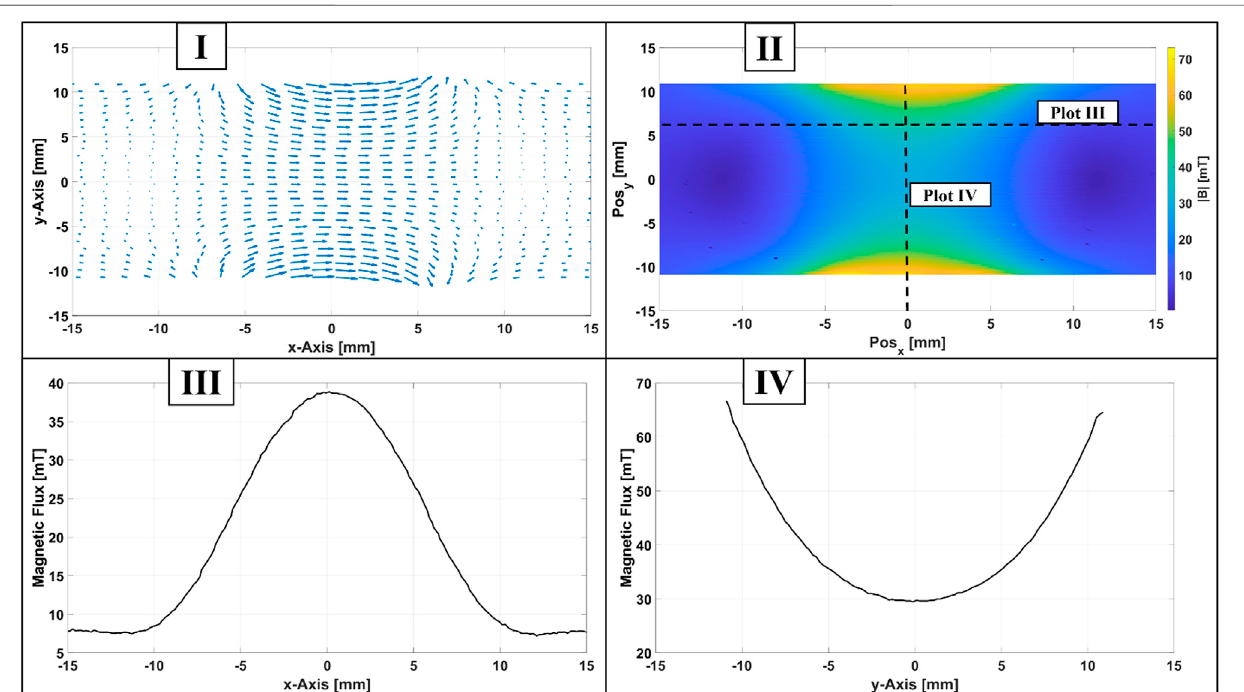
FIGURE 11 | Magnetic fi eld measurement results from the BSCCO setup: (I) Vector diagram of the magnetic fl ux in 2D; (II) Magnetic fl ux intensity in 2D along the centreplane; (III) Magnetic fl uxvaluesplottedverticallyalongthecentral regioninthemagnetarray; (IV) Magnetic fl uxvaluesplottedhorizontallyat6 mm distance tothe ring centre where the current lead is located during thrust measurements.